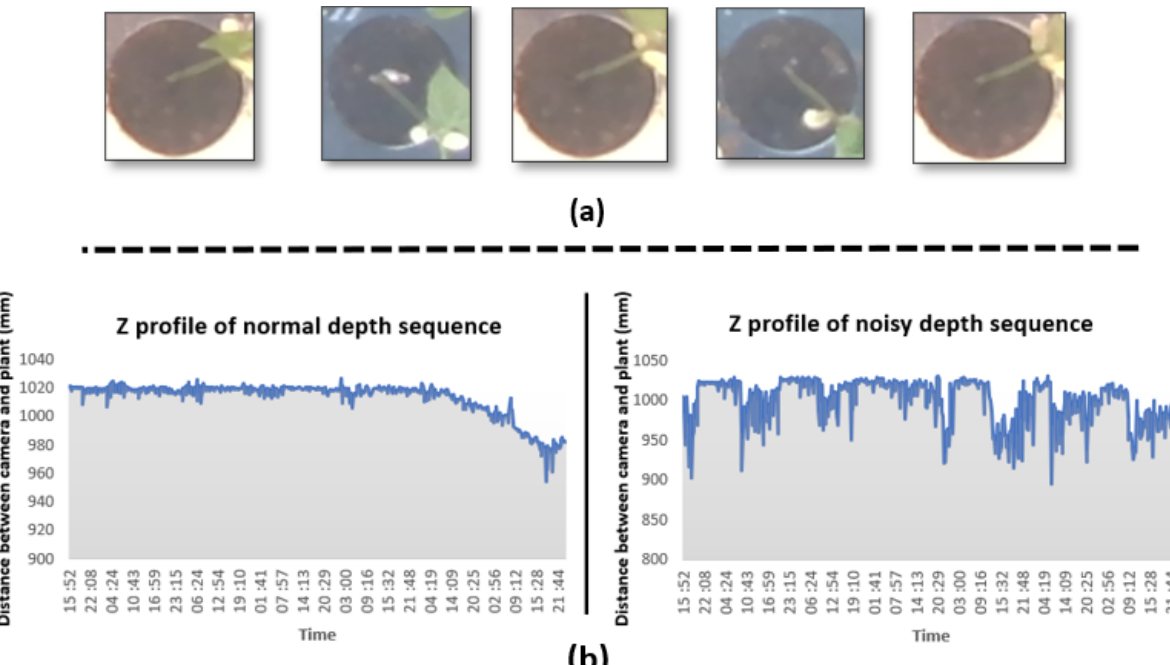
Figure 9. Sources of errors due to the acquisition protocol ( a ) and instrumentation ( b